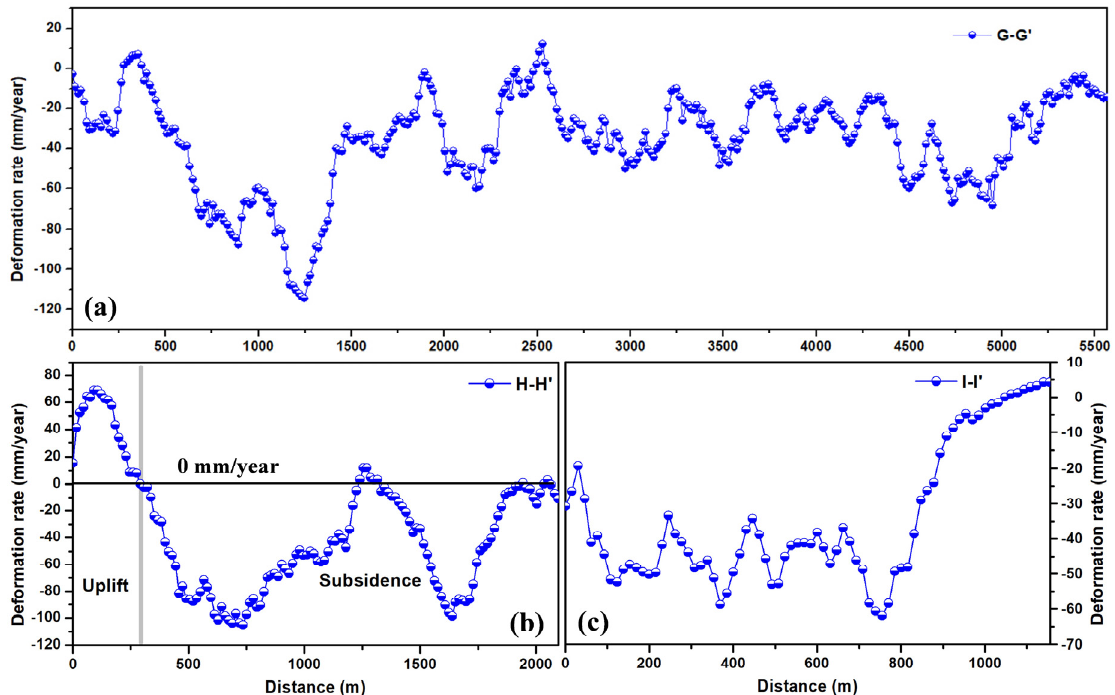
Figure 10. Average deformation rates in the vertical direction of Region E and F from January 2017 to October 2018 along three profiles (positions are indicated as black solid lines in Figure 9b). ( a ) Profile G–G’; ( b ) profile H–H’; ( c ) profile I–I’.